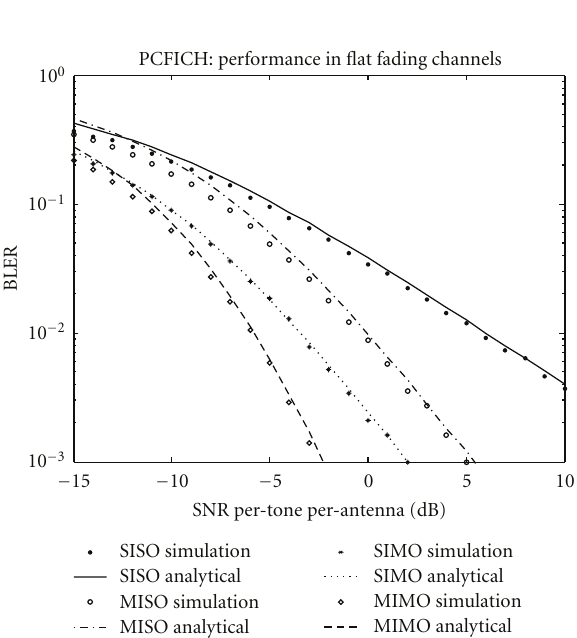
Figure 2: PCFICH performance in flat-fading